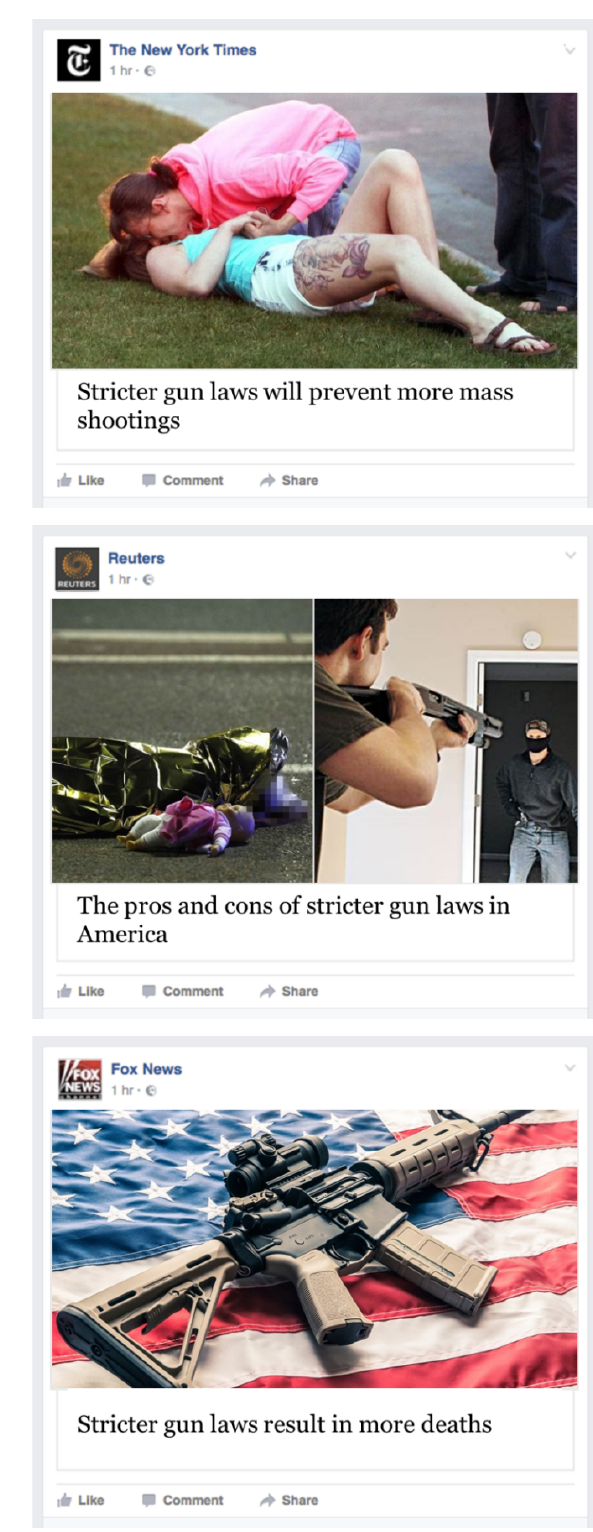
Figure 3. Example of three stimulus news items from Study 2, for the gun context and including sources. Notes: matching image-headline pairs are shown for the pro (top), balanced (middle) and anti-gun laws (bottom) con- ditions. In total the stimulus newsfeed contained nine im- migrations news items, comprising all possible matching and non-matching image-headline